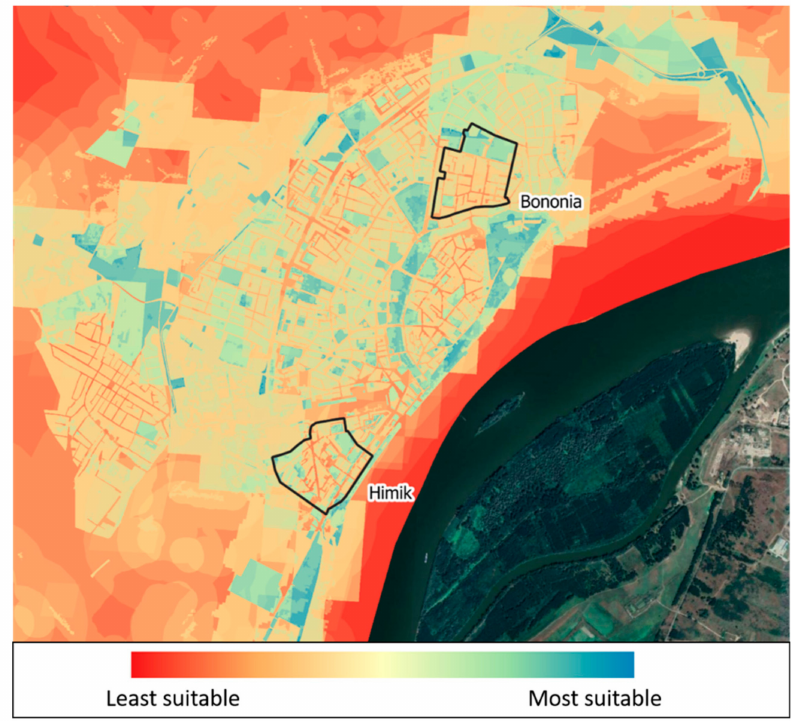
Figure 4. Vidin preselected and candidate areas to become